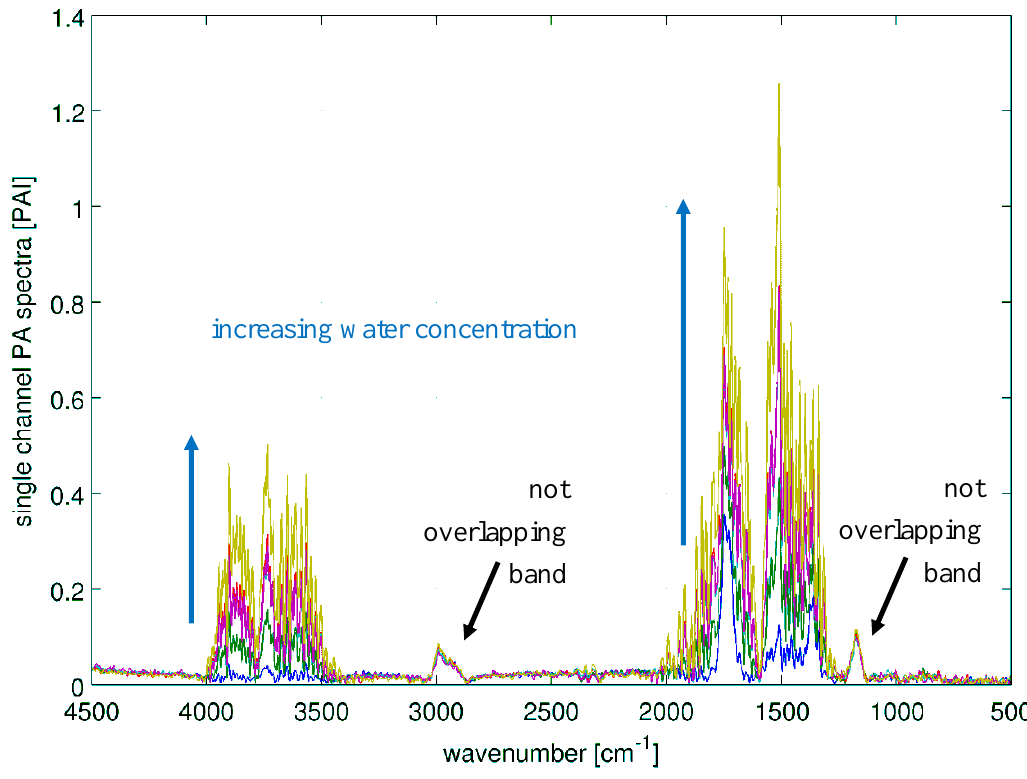
Figure 9. Water subtraction experiment: MEK concentration was always 200 ppm while the water concentration were 1,400, 4,200, 12k, 35k and 100k